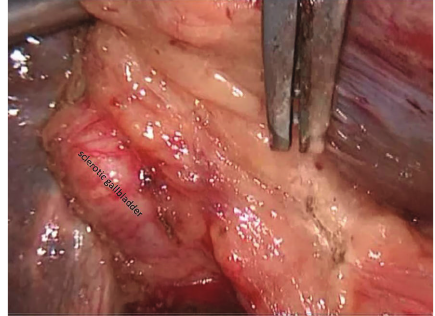
Figure 1: Sclerotic gallbladder is seen.